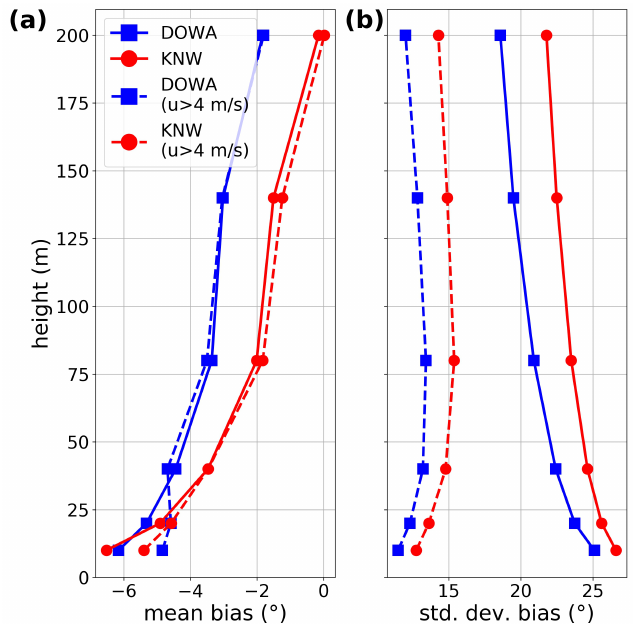
Figure 10. Height profile of ( a ) the mean bias (measurement minus model) and ( b ) standard deviation of the bias of the wind direction data, comparing the DOWA (blue) and KNW atlas (red). Solid lines are all data, dashed lines only data with wind speed larger than 4